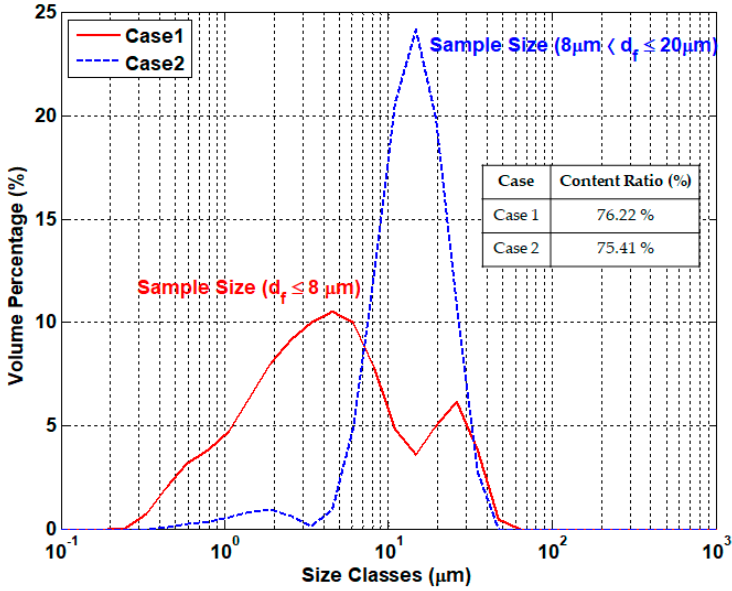
Figure 2. Grain-size distribution of manganese nodule tailing samples.